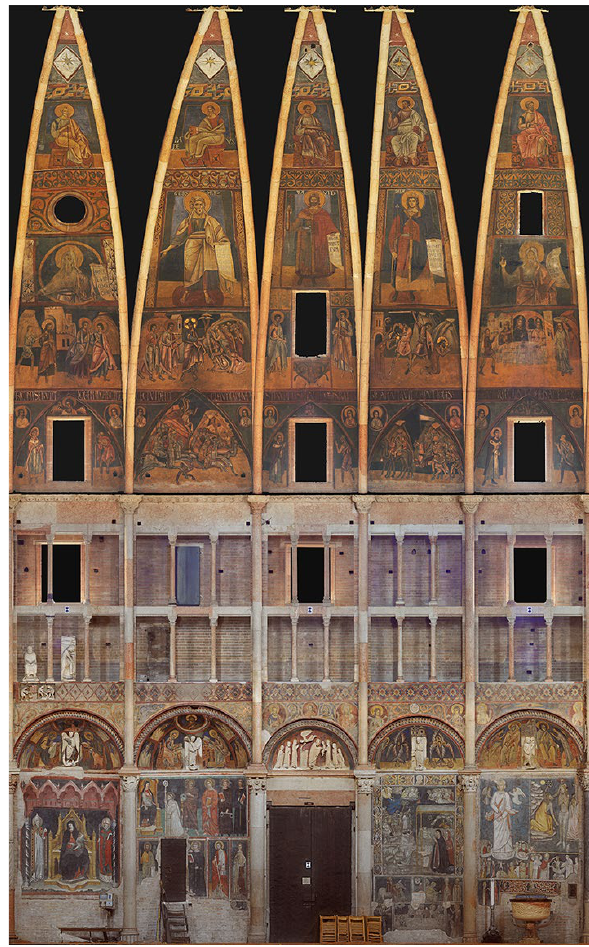
Figure 7. Particular of the ortophoto of the